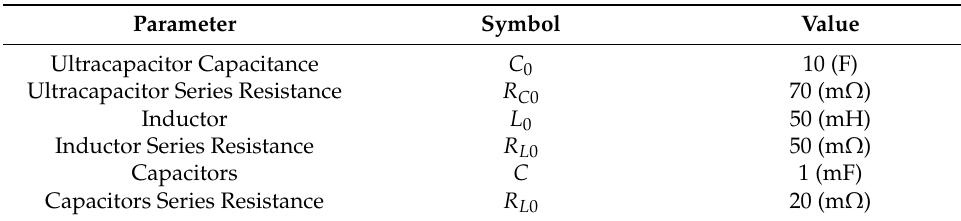
Table 3. 3-Level DC/DC/SVPWM topology.